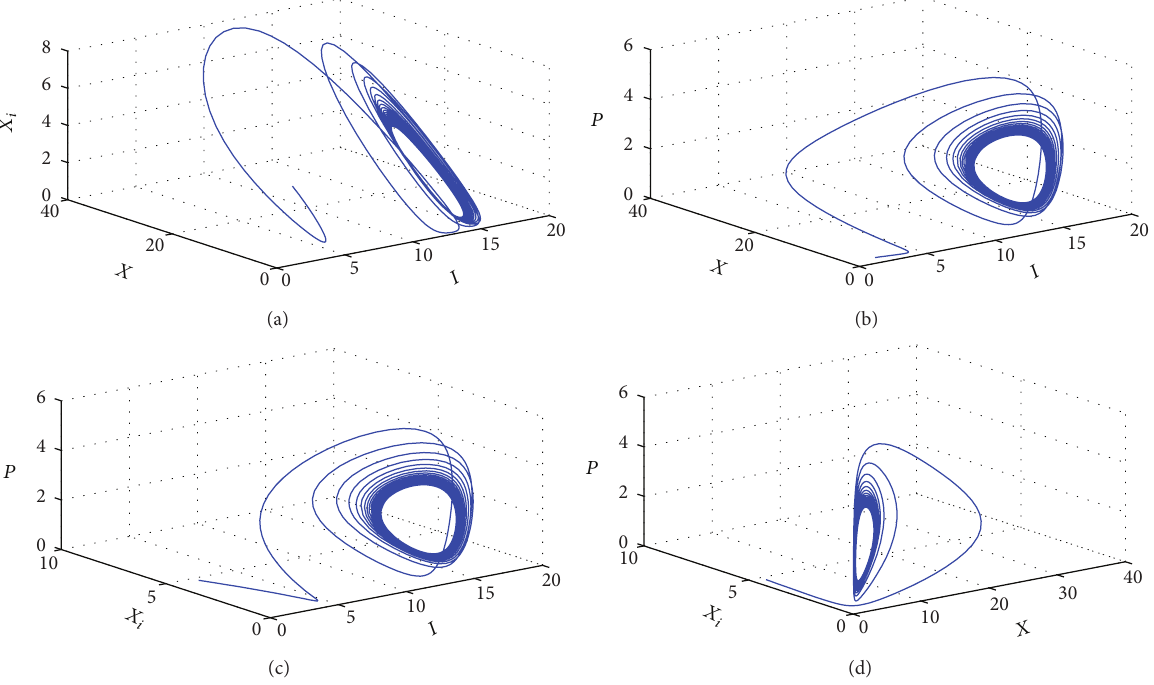
Figure 5: Numerical simulation for Case 2, with 𝑎 = 0.03 , ℎ = 0.12 , and other parameters fixed in Table 1. A stable limit cycle occurs for system (2).